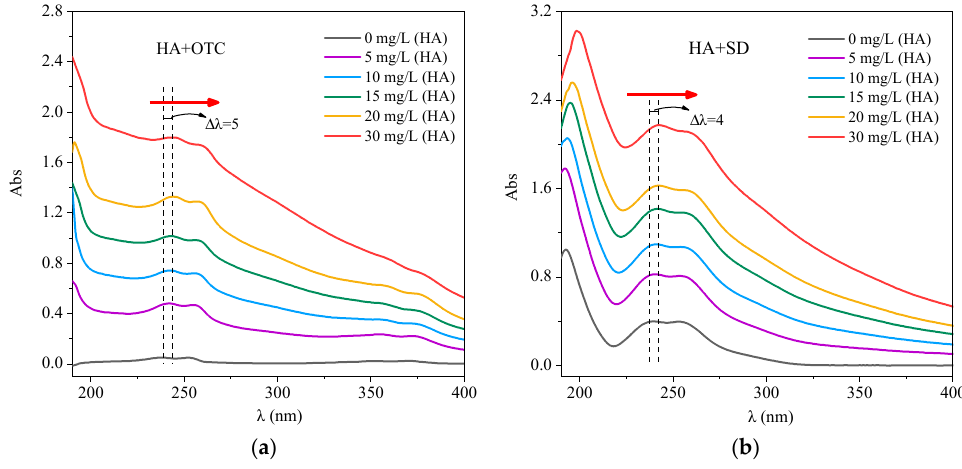
Figure 2. The interactions of different concentrations of HA with OTC and SD. ( a ) OTC; ( b ) SD.